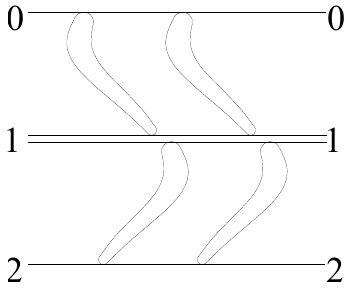
Figure 3. Drilling fluid flow in the turbodrill blade.